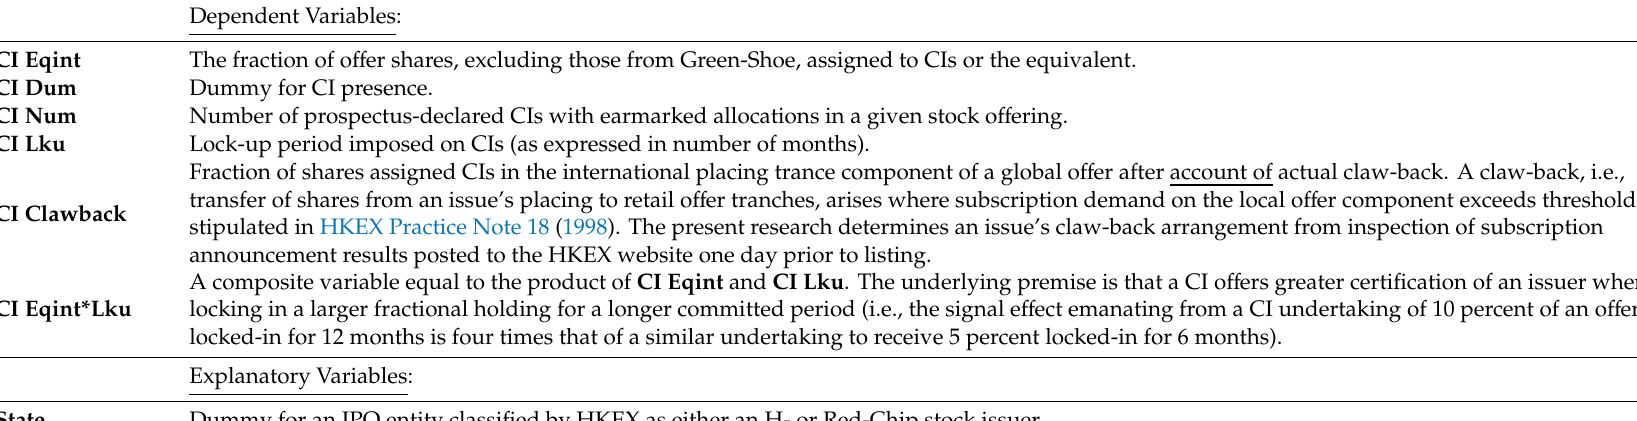
Table 1. (a) Summary of variable characteristics relevant to Equation (1). (b) Descriptive statistics of Equation (1)